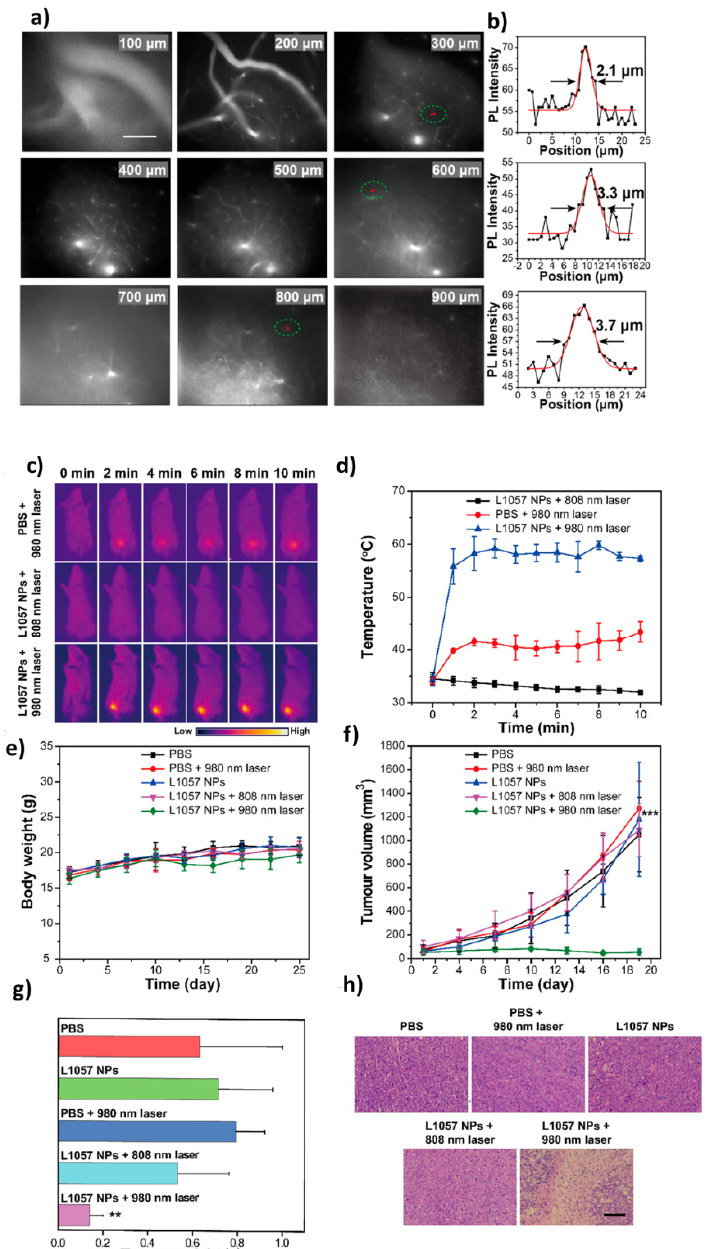
Figure 5. Real-time in-vivo NIR-II fluorescence microscopic imaging of mouse brain vasculature. ( a ) Cerebrovascular imaging at various depths (100–900 μ m) after the intravenous injection of L1057 NPs. The excitation wavelength was 980 nm. Scale bar: 100 μ m. ( b ) Cross-sectional fluorescence intensity profiles (and Gaussian fits (red) with fwhm indicated by arrows) along the red lines circled with green in panel a; PTT efficacy of L1057 NPs on tumors. ( c , d ) PTT images ( c ) and corresponding temperature changes ( d ) of 4T1-tumor-bearing mice under irradiation with an 808 (0.33 W/cm 2 ) or 980 nm (0.72 W/cm2) laser. ( e , f ) Body weight ( e ) and tumor volume ( f ) curves of tumor-bearing mice at different time points after receiving PTT. ( g , h ) Tumor weight ( g ) and H&E staining ( h ) of the tumor tissues from mice sacrificed at day 18 post-PTT treatment. Scale bar: 100 μ m. Results are presented as the mean ± S.D., n = 5. Statistical significance was calculated using one-way ANOVA with the Tukey posthoc test. *** p < 0.001. (Reprinted Permission from American Chemical Society, 2020) [61].